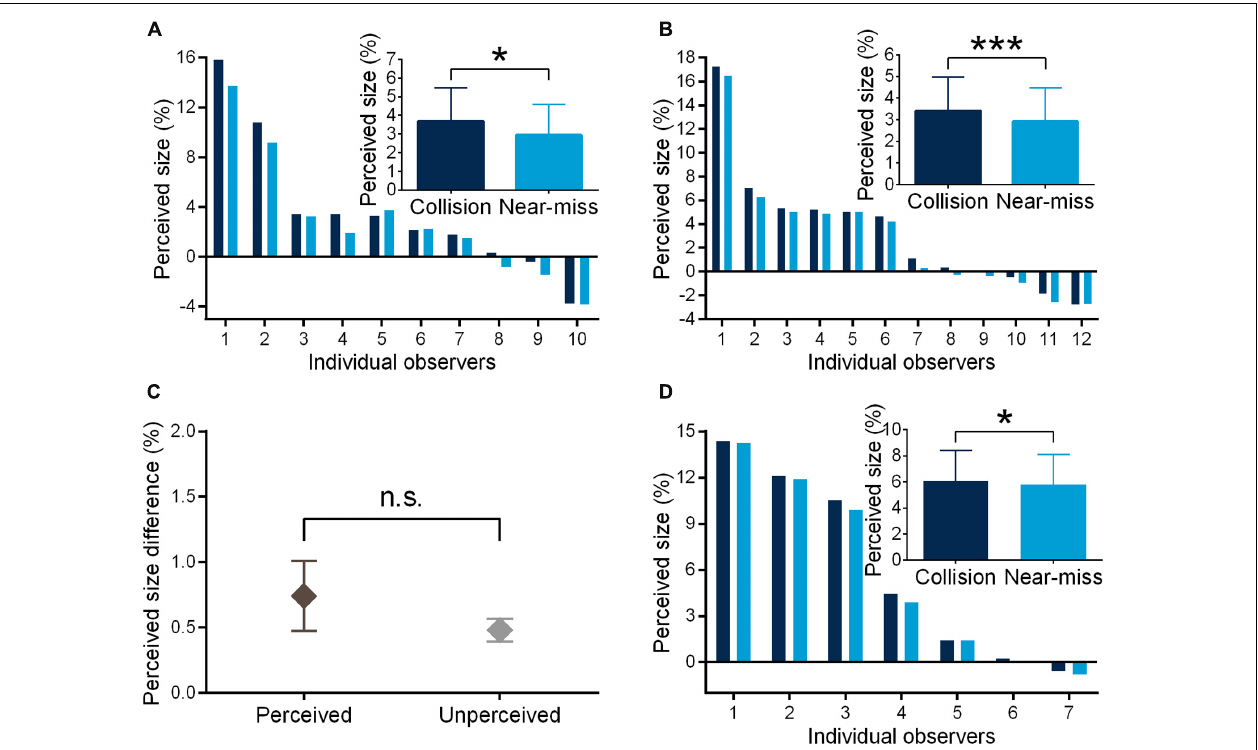
FIGURE 2 | Perceived size of the looming spheres in the threat-perceived (A) and -unperceived (B) conditions, respectively. (C) The perceived size discrepancies between the collision and near-miss spheres were similar in the two conditions. Perceived size of the looming spheres with black background in the threat-unperceived condition (D) . ∗ p < 0.05, ∗∗∗ p < 0.001. The error bars represent one standard error of the mean. The perceived size of the sphere was calculated relative to its standard size.